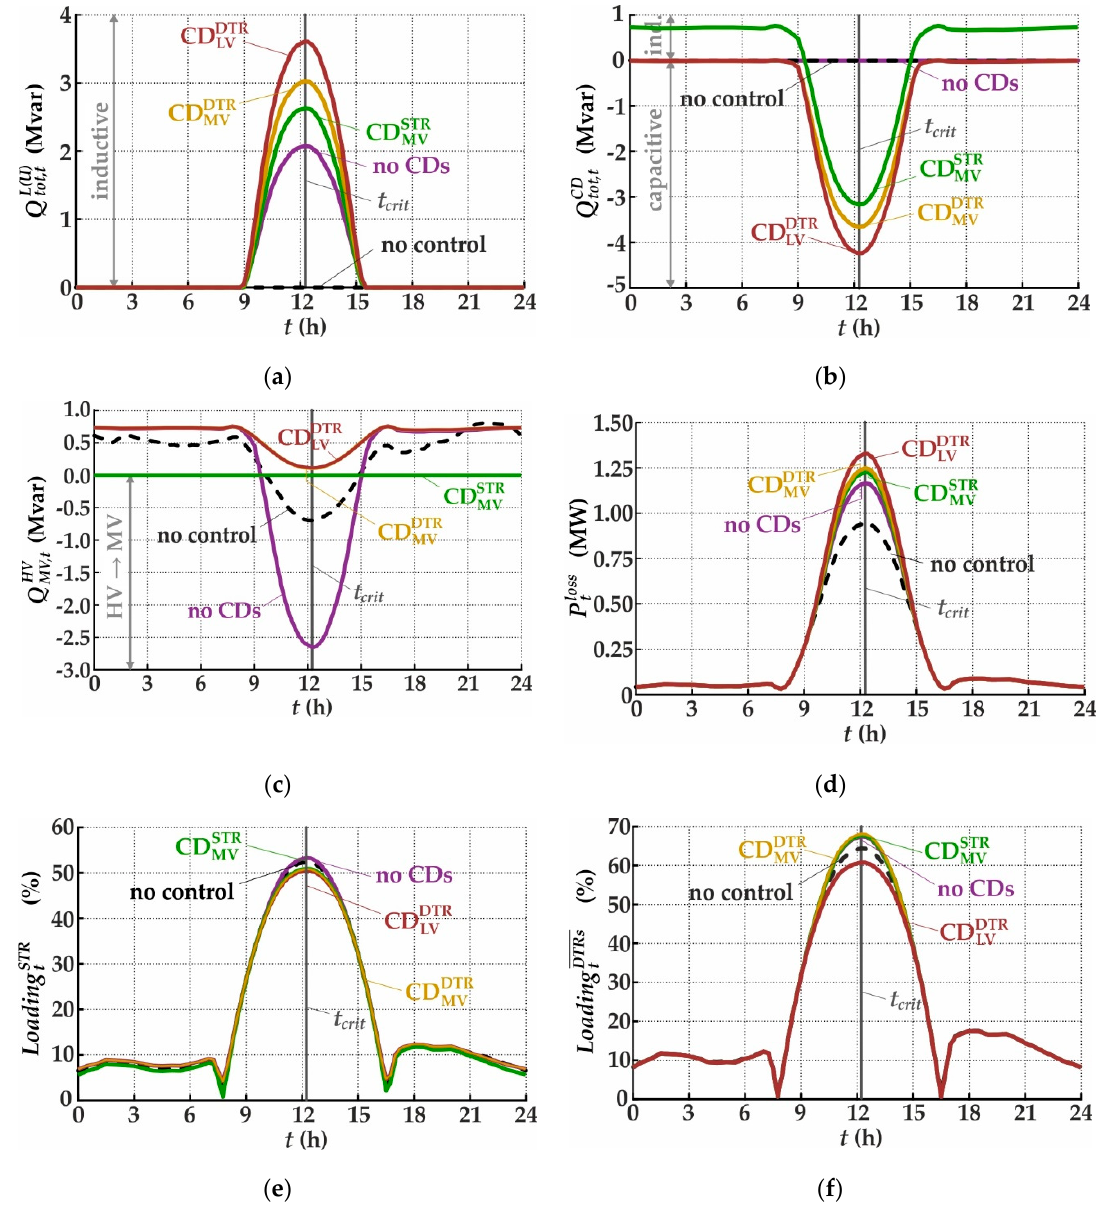
Figure 11. Behaviour of the distribution grid with cable conductors in MV level for a 24 hour time horizon and different control strategies: ( a ) Q -consumption of L ( U )s; ( b ) Q -contribution of CDs; ( c ) Q -exchange between HV_ and MV_link-grid; ( d ) active power losses; ( e ) STR loading; ( f ) mean DTR loading.